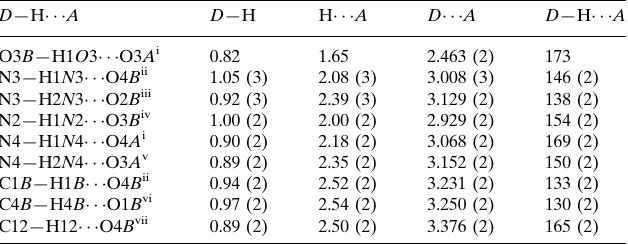
Hydrogen-bond geometry (A˚ , (cid:4) ). D —H (cid:2)(cid:2)(cid:2)